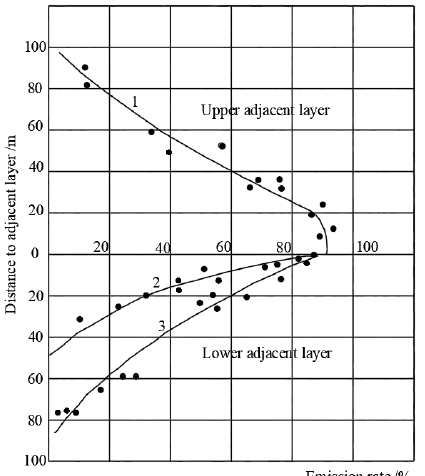
Figure 8. Relationship curve between gas emission rate of adjacent coal seam and layer spacing.